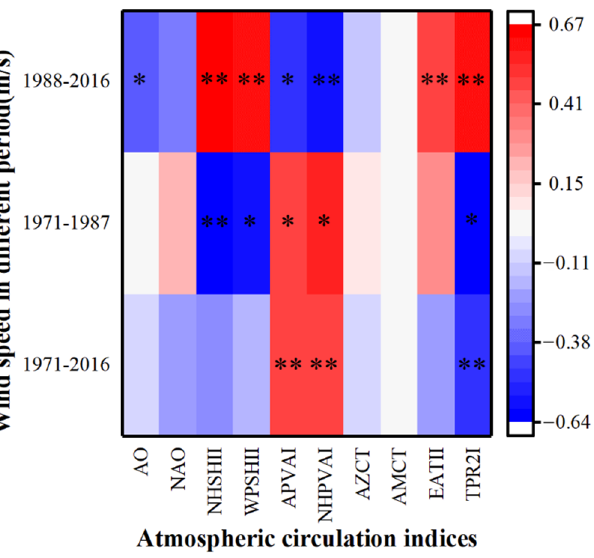
Figure 4. Related coefficient between wind speed and atmospheric circulation indices in different periods in the BJD (* The significance level is 0.05, ** The significance level is 0.01).